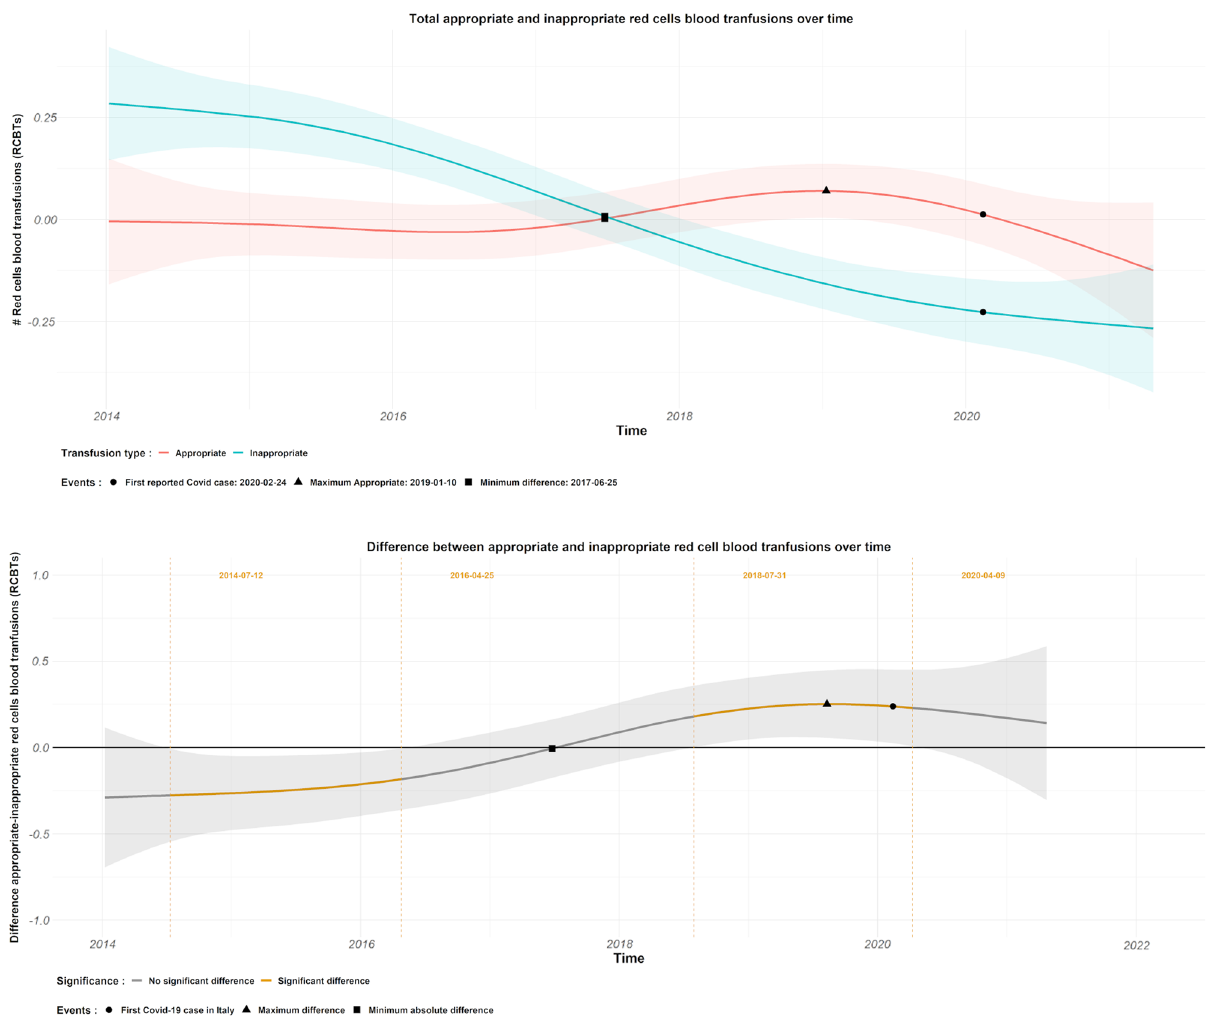
Figure 1. Top panel: Average (across hospitals and medical wards) smooth time trends for appropriate (red) and inappropriate (blue) RBCTs with their corresponding 95% CI. The time of zero difference between the two smooth functions is denoted by a square, the time of maximum appropriate RBCTs with a triangle, and the time of the first COVID-19 reported case in the region by a circle. Bottom panel: Estimated difference (appropriate– inappropriate) with 95% CI between the average smooth time trends of appropriate and inappropriate RBCTs. Time periods of significant difference (zero not included in the 95% CI) between the two smooth components are highlighted in yellow. The timepoint of the maximum difference between the two smooth components is visualized by a